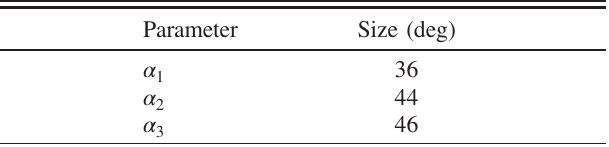
TABLE II. The values of the geometrical parameters for the different angles shown in Fig. 7.